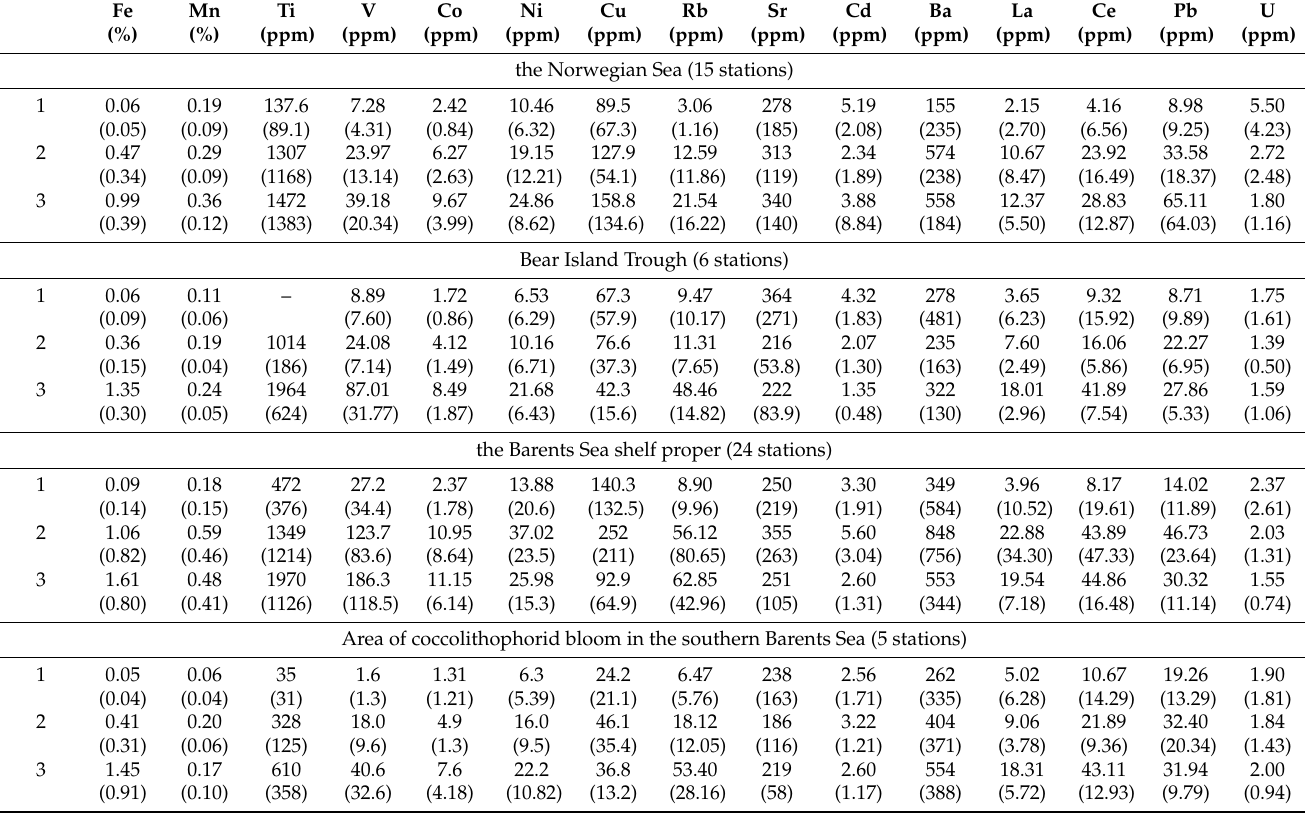
Table 3. Element content in SPM of euphotic layer (1), intermediate layer (2), and BBL (approximately 50 m from the bottom) (3). Standard deviation values are indicated in the